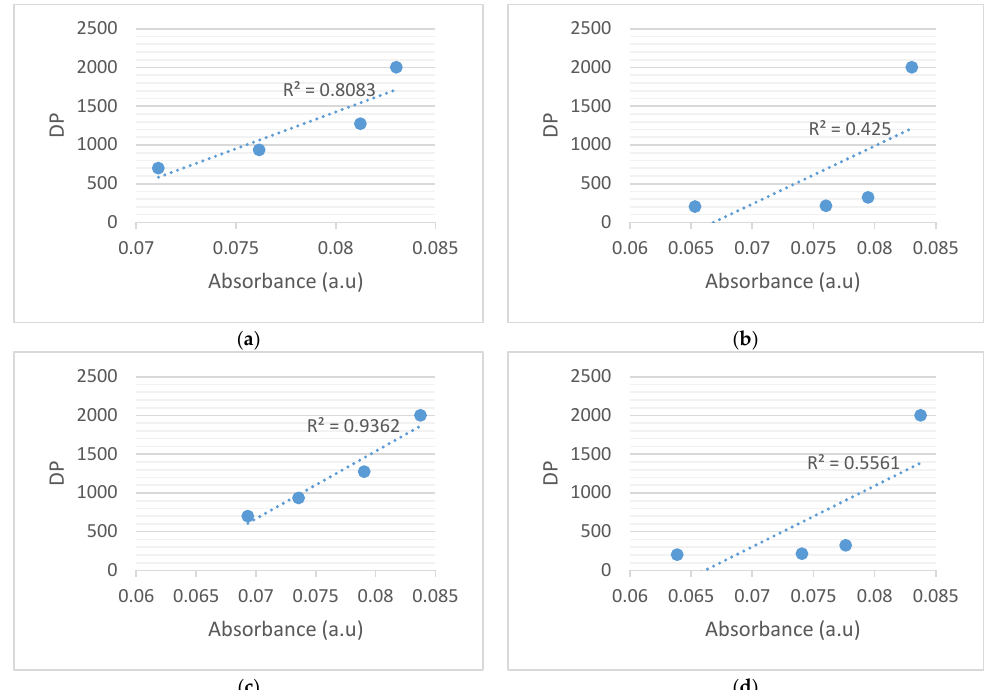
Figure 14. Correlation between average number of chain scission of transformer insulation paper and intensity of peaks absorbance of O–H functional group at aging temperature ( a ) 120 ◦ C (3325 cm − 1 ); ( b ) 150 ◦ C (3325 cm − 1 ); ( c ) 120 ◦ C (3273 cm − 1 ); ( d ) 150 ◦ C (3273 cm − 1 ).